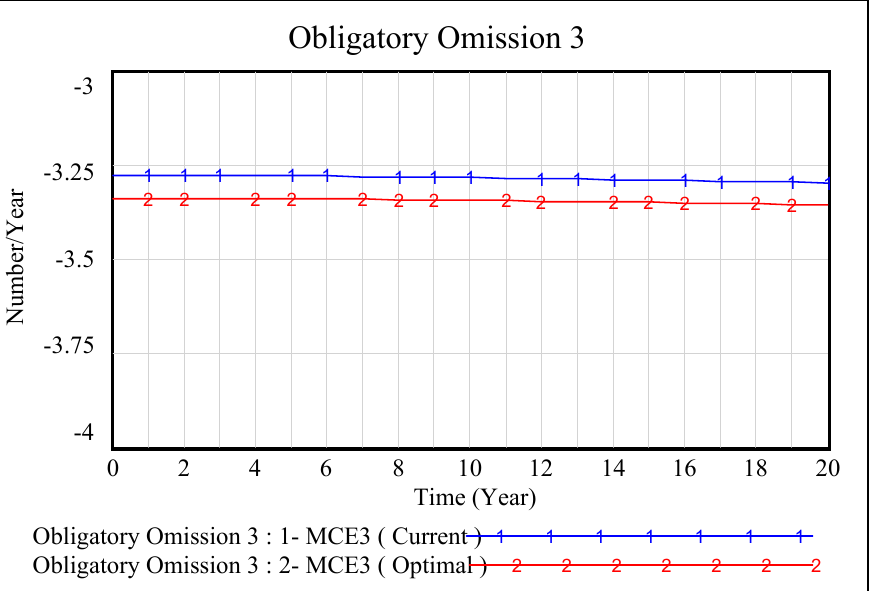
Figure 16. Comparison of the effect of the current and optimal amount of the obligatory omission rate 3 on the current variable of obligatory omission 3.